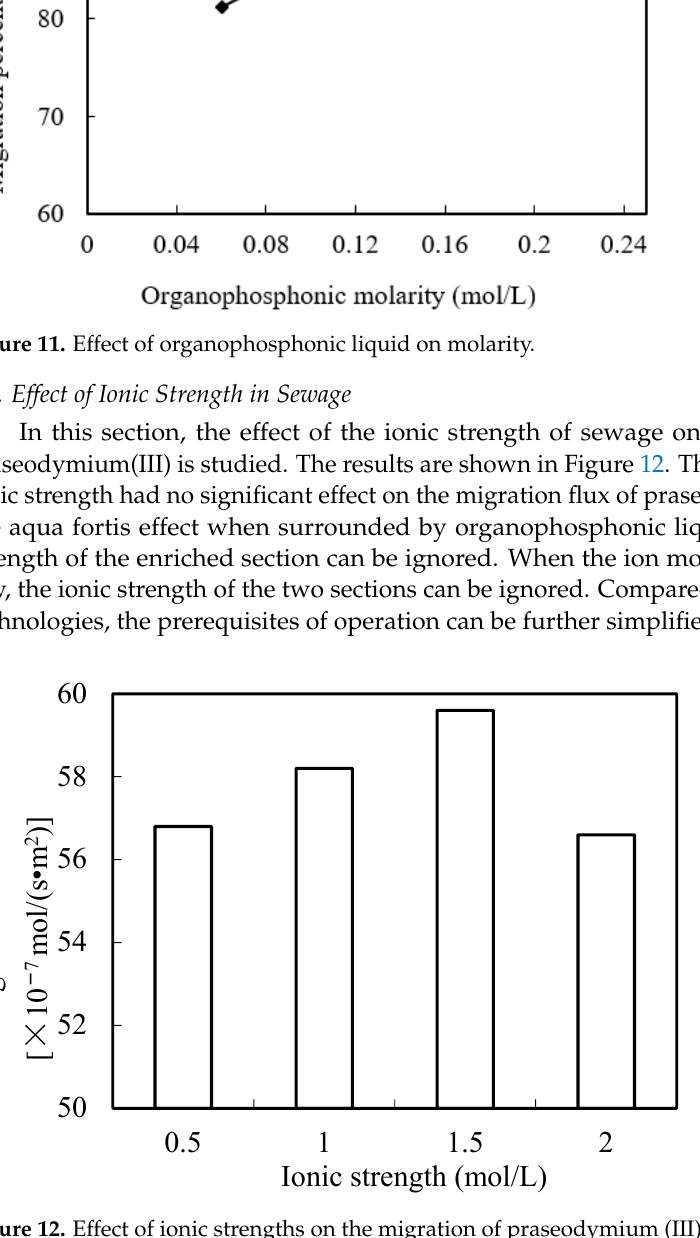
Figure 12. Effect of ionic strengths on the migration of praseodymium (III).